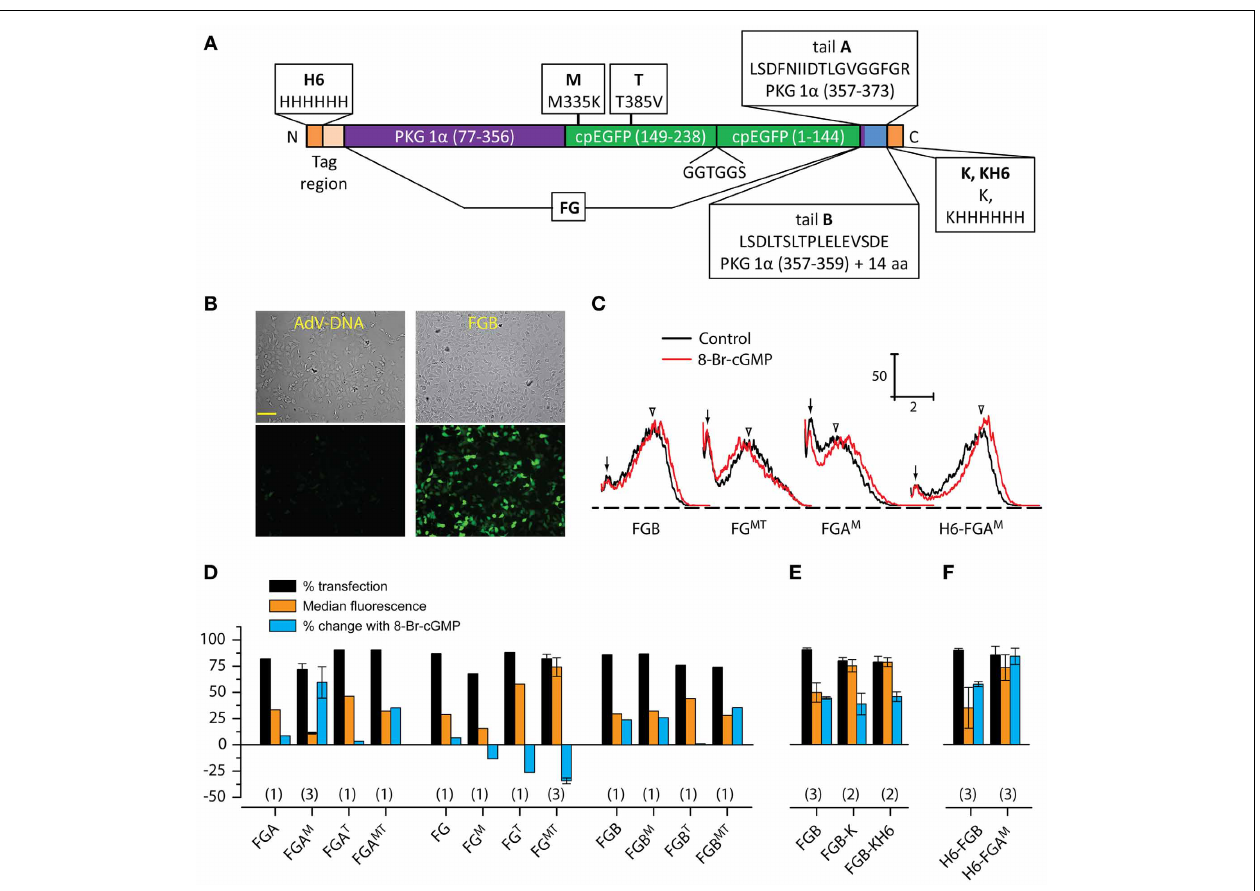
indicated FlincG variants, before (black) and after (red) incubation with 8-bromo-cGMP (1mM). Calibration bars: vertical = frequency; horizontal = log intensity (arbitrary units). Arrows and arrowheads indicate untransfected and transfected components of the control spectra, respectively. (D–F) Results of FACS analysis for groups of FlincG variants; plasmids in panel D all bore a strong Kozak consensus sequence (see Material and Methods). Numbers in parentheses are n